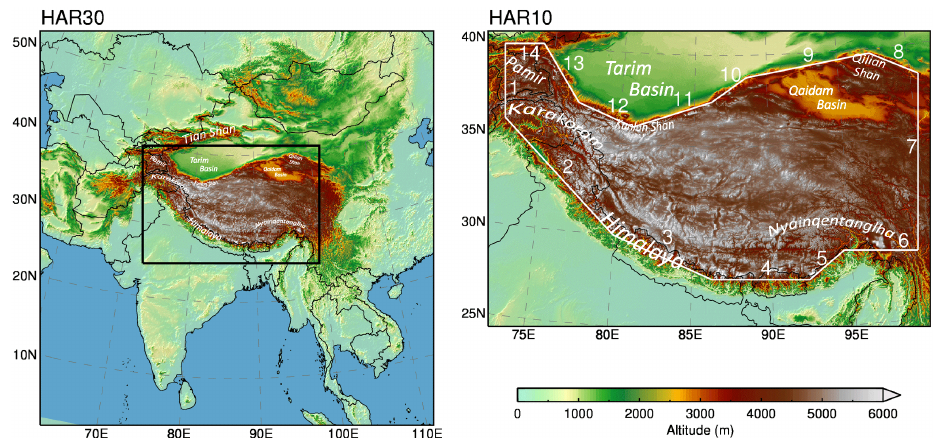
Figure 1. Maps of the Weather and Research Forecasting (WRF) model domains HAR30 (south-central Asia domain, 30km resolution) and HAR10 (high Asia domain, 10km resolution). The transects surrounding the Tibetan Plateau (numbered 1–14) are drawn in white. The region within the defined boundaries is called “inner TP” throughout the manuscript. Geographical locations are indicated (modified after Maussion et al.,